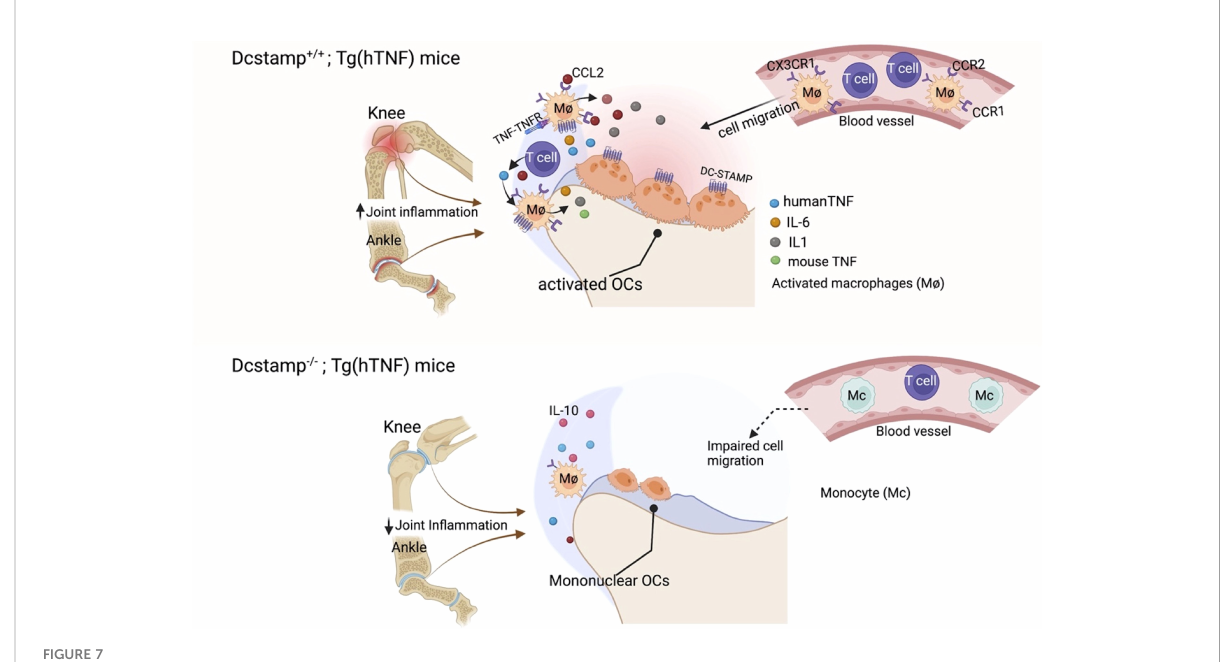
FIGURE 7 DC-STAMP enhances in fl ammation and bone resorption. TNF activates monocytes/DCs, which secrete pro-in fl ammatory cytokines and chemokines capable of recruiting innate immune cells, T cells and activating osteoclast precursors. DC-STAMP enhances TNF and CCL2 production by synovial in fi ltrating T cells and macrophages. In addition, bone resorption is impaired in the absence of DC-STAMP due to the inability of the OCPs to fuse and form a polykaryon. Thus, the reduction in in fl ammation and bone damage in Dcstamp -/- ;Tg(hTNF) de fi cient is the result of amelioration of DC-STAMP driven in fl ammation and